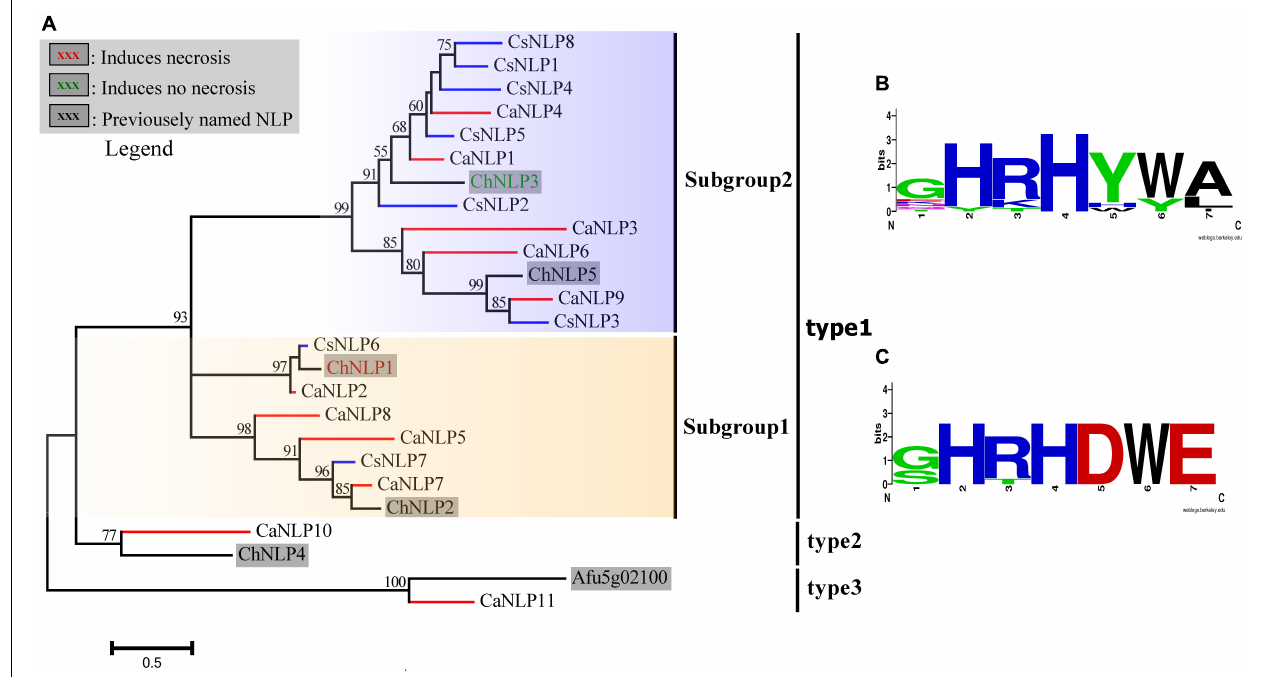
FIGURE 8 | (A) Phylogenetic reconstruction of secreted necrosis- and ethylene-inducing peptide 1 (Nep1)-like proteins (NLPs). Blue branches show the NLPs of Colletotrichum siamense ; red branches show the NLPs of C. australisinense . (B) Aligned Weblogo of the conserved motif GHRHDWE sequence of subgroup-2. (C) Aligned Weblogo of the conserved motif GHRHDWE sequence of subgroup-1. ChNLP1, ChNLP2, ChNLP3, ChNLP4, ChNLP5 (Kleemann et al., 2012) and Afu5g02100 (Upadhyay et al., 2012) were used for reference sequence of different type NLP (Oome and Van den Ackerveken,